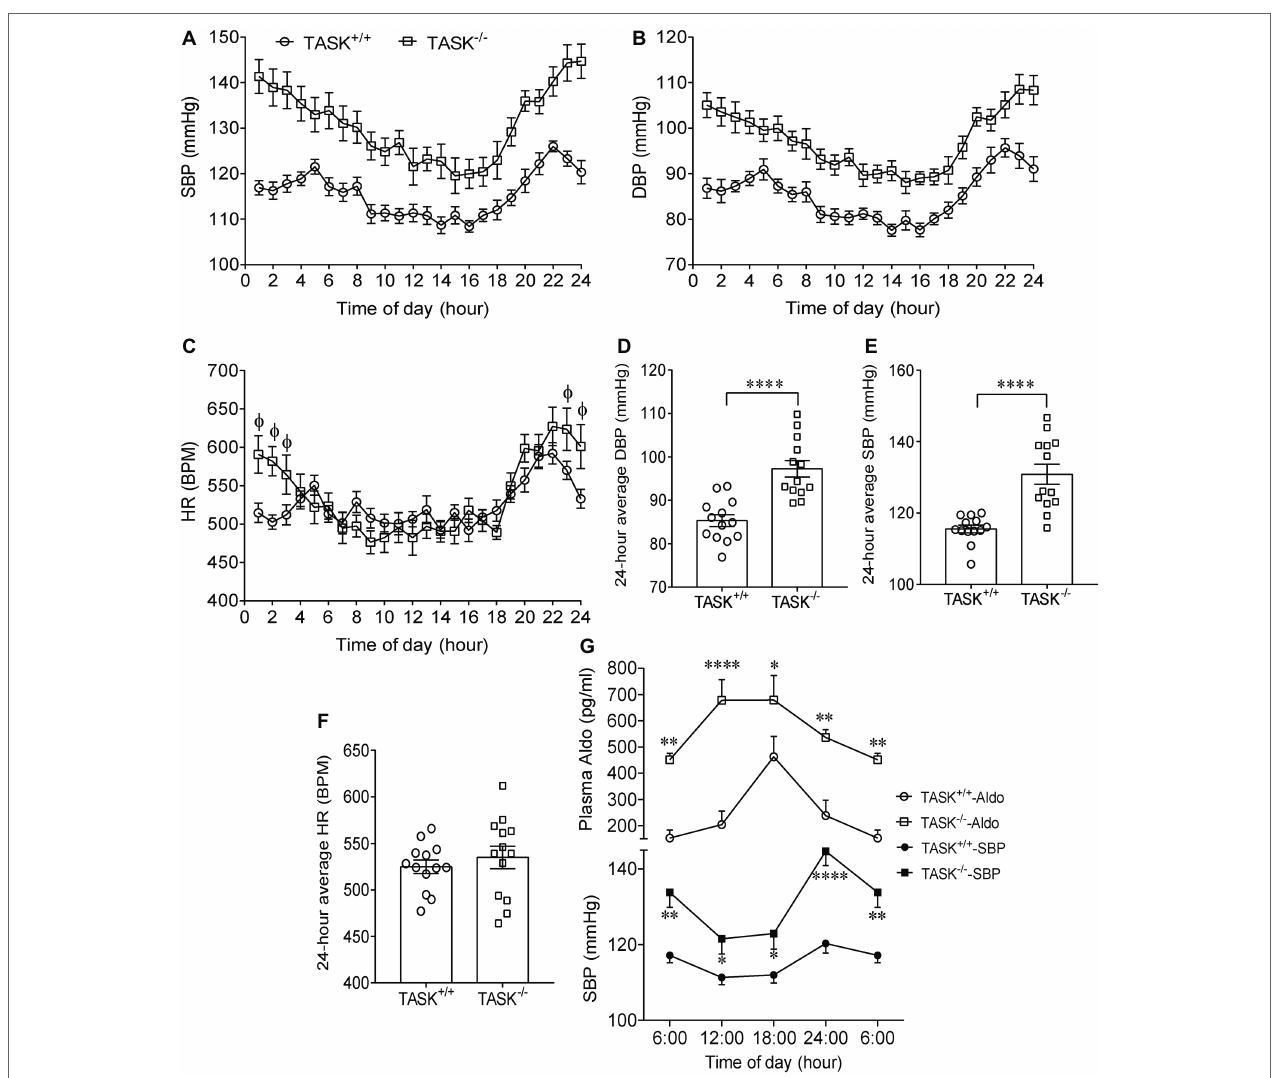
FIGURE 1 | Hypertension in TASK − / − mice. Continuous telemetric recordings of SBP, DBP, and HR over 24-h period were performed in TASK +/+ and TASK − / − mice ( n = 13 for each genotype). Measurements were made hourly over 24 h. (A–C) Dynamic SBP, DBP, and HR over 24 h. SBP and DBP were significantly higher at each time point over 24 h in TASK − / − mice compared to TASK +/+ mice ( p < 0.05, two-way ANOVA with Fisher’s LSD post hoc test). HR measured over 24 h in TASK − / − mice was not different from control mice, except for higher HR at specific time points ( p < 0.05 as indicated by Φ , two-way ANOVA with Fisher’s LSD post hoc test). (D–F) 24-h average SBP, DBP, and HR. **** p < 0.0001 as indicated, unpaired t test. (G) Circadian changes in plasma Aldo and arterial pressure. Top panel: plasma level of Aldo was measured at 6:00, 12:00, 18:00, and 24:00. n = 16 mice for each genotype. Bottom panel: telemetric recordings of SBP. n = 13 mice for each genotype. * p < 0.05, ** p < 0.01, **** p < 0.0001 by two-way ANOVA with Fisher’s LSD post hoc test, TASK − / − versus TASK +/+ mice. SBP, systolic blood pressure; DBP, diastolic blood pressure; HR, heart rate; BPM, beat per